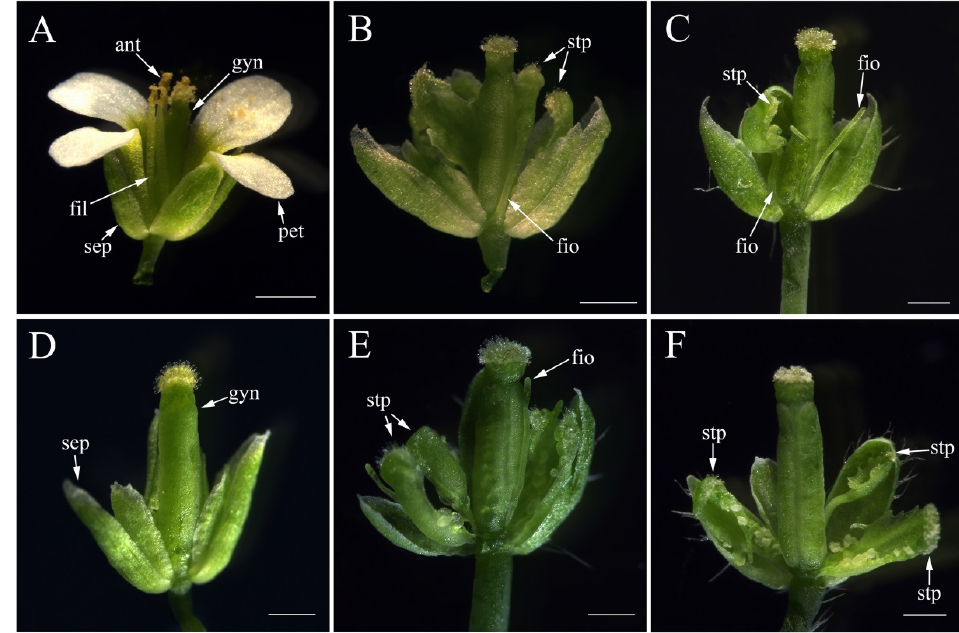
Figure 8. Flower phenotypes of wild-type, Arabidopsis pi-1 mutant, pFaesPI_1::FaesPI_1 transgenic pi-1 Arabidopsis, and pFaesPI_2::FaesPI_2 transgenic pi-1 Arabidopsis . ( A ) wild-type Arabidopsis flower with perfect flower (sepal in the first floral whorl, petal in the second floral whorl, stamen in the third floral whorl and fused carpel in the fourth floral whorl); ( B ) flower of pFaesPI_1::FaesPI_1 trans- genic homozygous pi-1 Arabidopsis with carpelloid stamen or filament with stigmatic papillae at the top in the third floral whorl; ( C ) flower of pFaesPI_1::FaesPI_1 transgenic homozygous pi-1 Arabidop- sis with filament and filament with carpelloid anther at the top in the third floral whorl; ( D ) flower of Arabidopsis pi-1 mutant exhibits homeotic transformations of the second floral whorl petal to se- pal, and stamen deficiency in the third floral whorl; ( E ) flower of pFaesPI_2::FaesPI_2 transgenic ho- mozygous pi-1 Arabidopsis with carpelloid stamen and filament-like organ in the third floral whorl; ( F ) flower of pFaesPI_2::FaesPI_2 transgenic homozygous pi-1 Arabidopsis with carpelloid stamen and